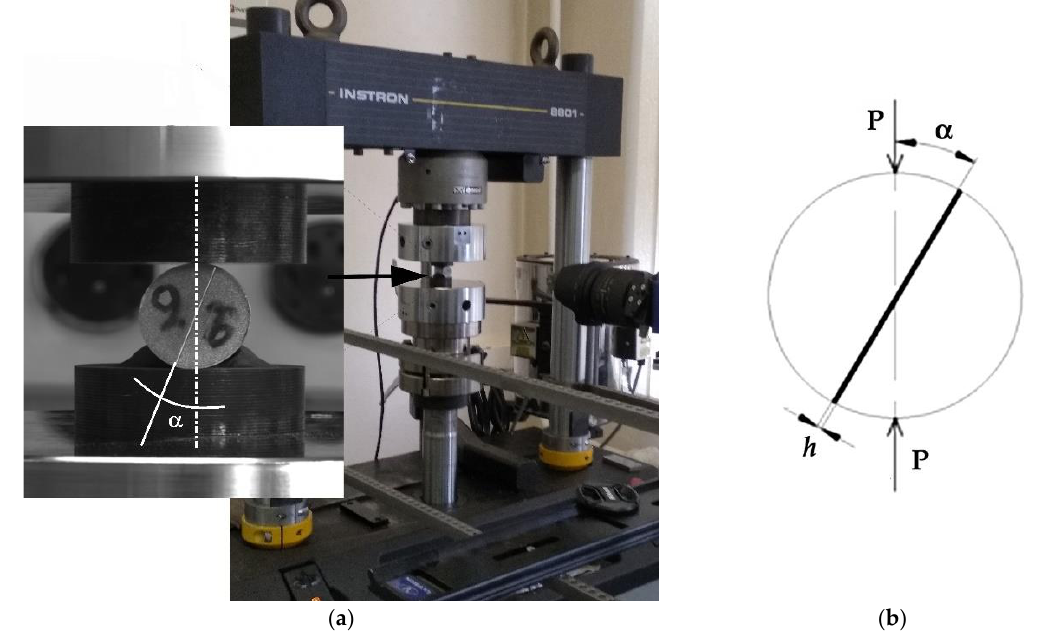
Figure 4. The Brazil-nut-sandwich mounted in the flat dies of the testing machine ( a ); load application pattern ( b ).